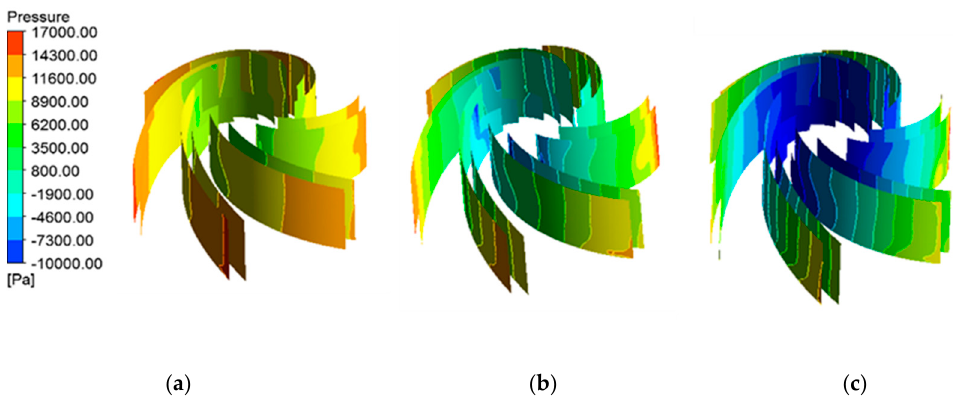
Figure 8. Pressure distribution of blades under different speeds with the flow rate of 5 L/min: ( a ) ω = 2330 r/min; ( b ) ω = 3330 r/min; ( c ) ω = 4330 r/min.